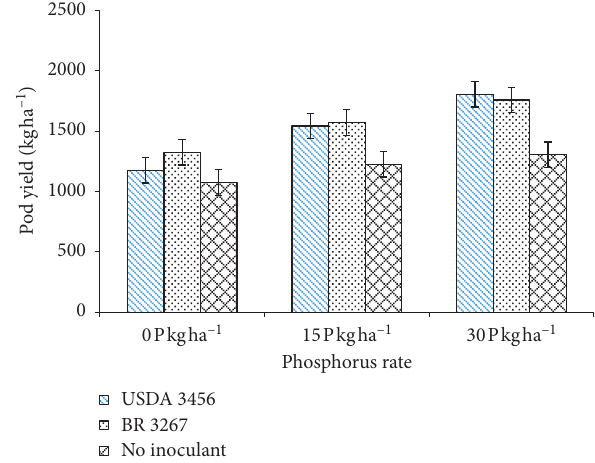
Figure 3: Influence of combined application of rhizobium inoc- ulant and P fertilizer on pod yield of groundnut (bars represent LSD at P < 0 . 05).